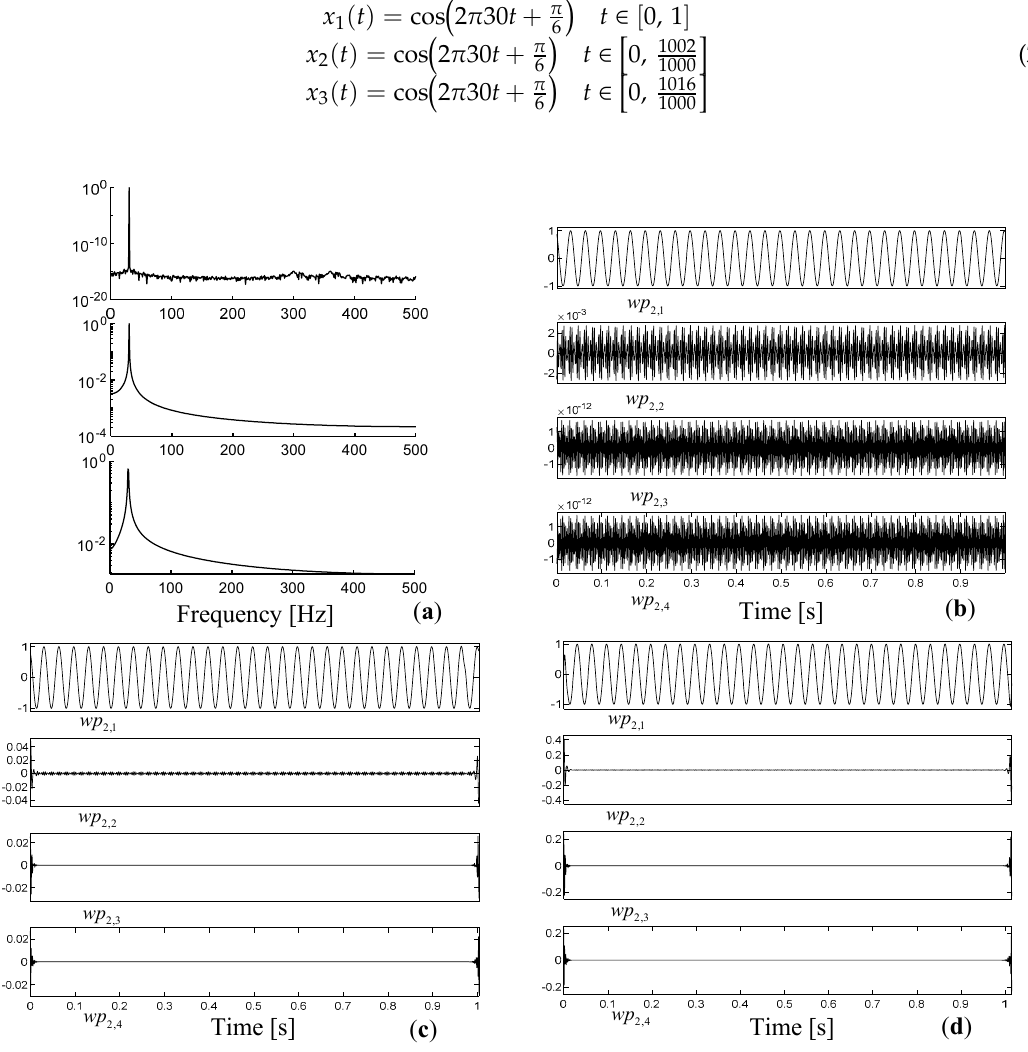
Figure 11. ( a ) FFT spectra of the three simulated signals; ( b ) decomposition results of x 1 ( t ) ; ( c ) decomposition results of x 2 ( t ) ; and ( d ) decomposition results of x 3 ( t )